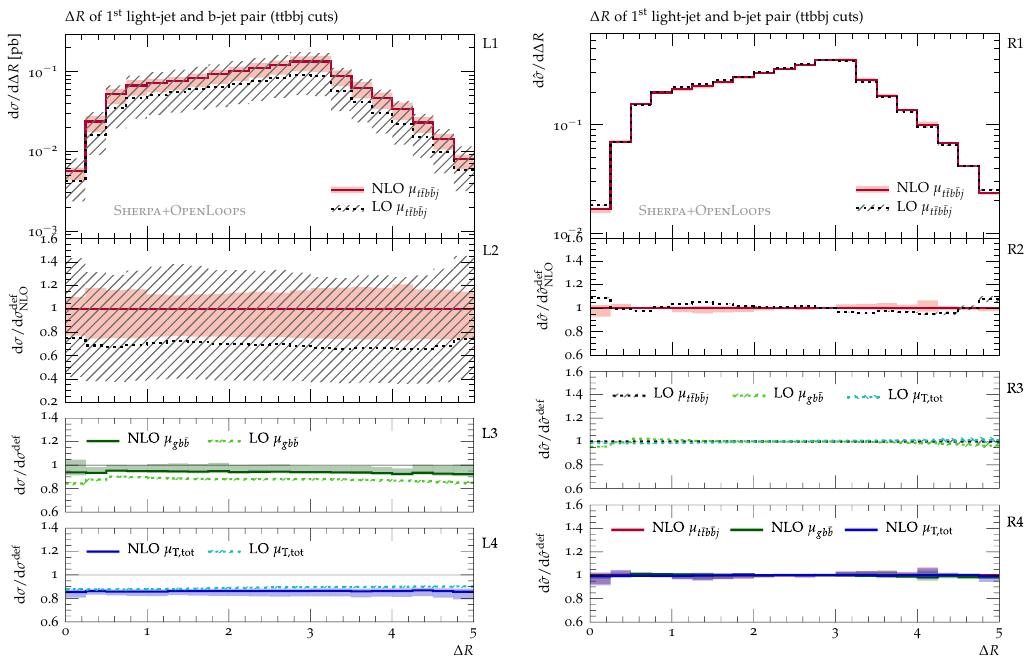
Figure 10. (cid:1) R between the light jet and the b -jet pair. Same setup and plots as in (cid:12)gure